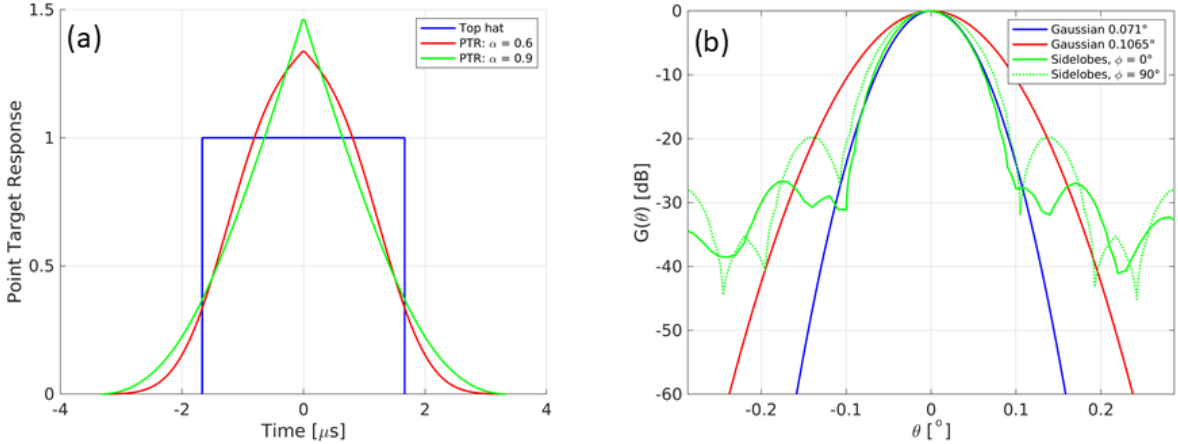
Figure 7. (a) Examples of point target responses that can be used as inputs in the simulator. The narrow top hat (blue curve) is the one adopted for the simulations. (b) Examples of antenna patterns that can be used as inputs in the simulator. The narrow Gaussian one (blue curve) is the one adopted for the simulations. The green ones correspond to the elevation and azimuthal cut of an antenna pattern for an elliptical antenna with